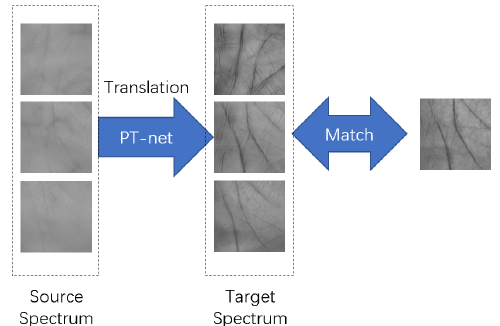
Figure 1. Proposed cross-spectral recognition